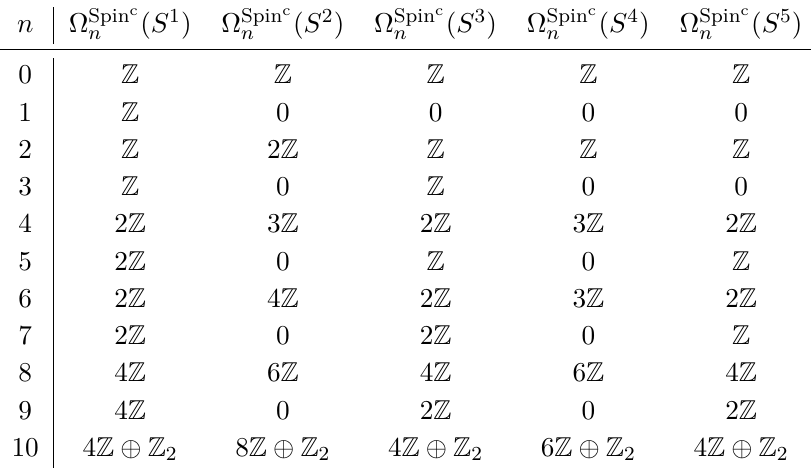
Table 22 . Spin c cobordism groups of spheres Ω Spin c